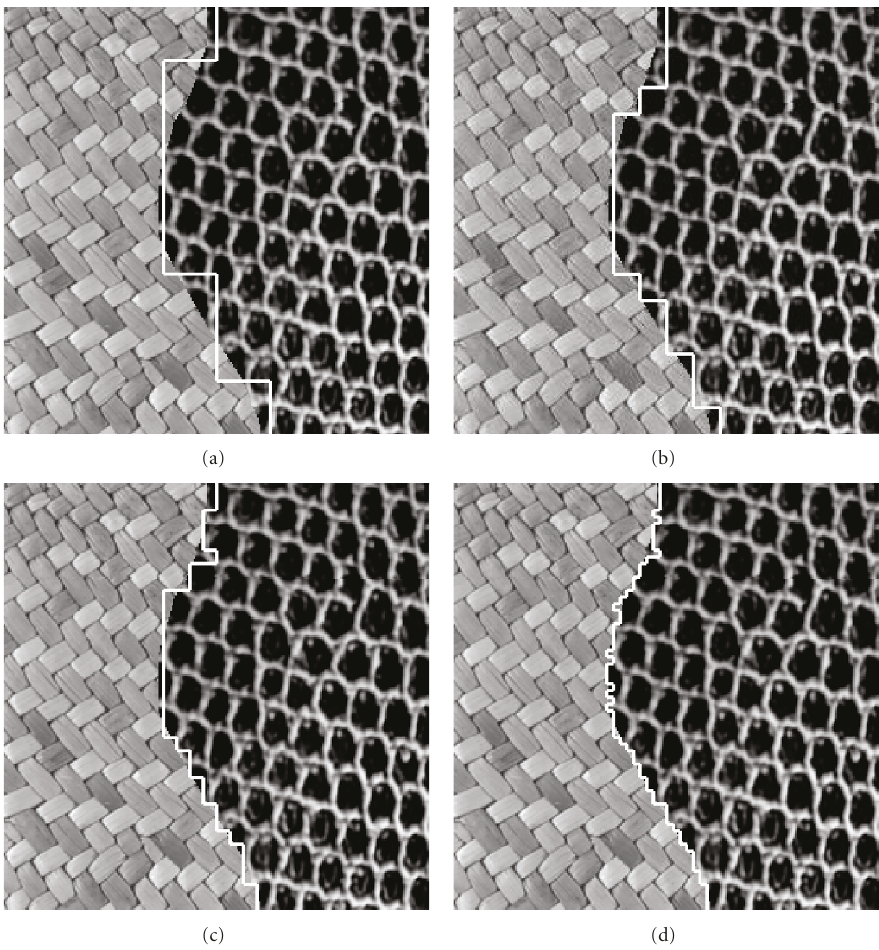
Figure 4: Segmentation results of Image I at 3 di ff erent resolution